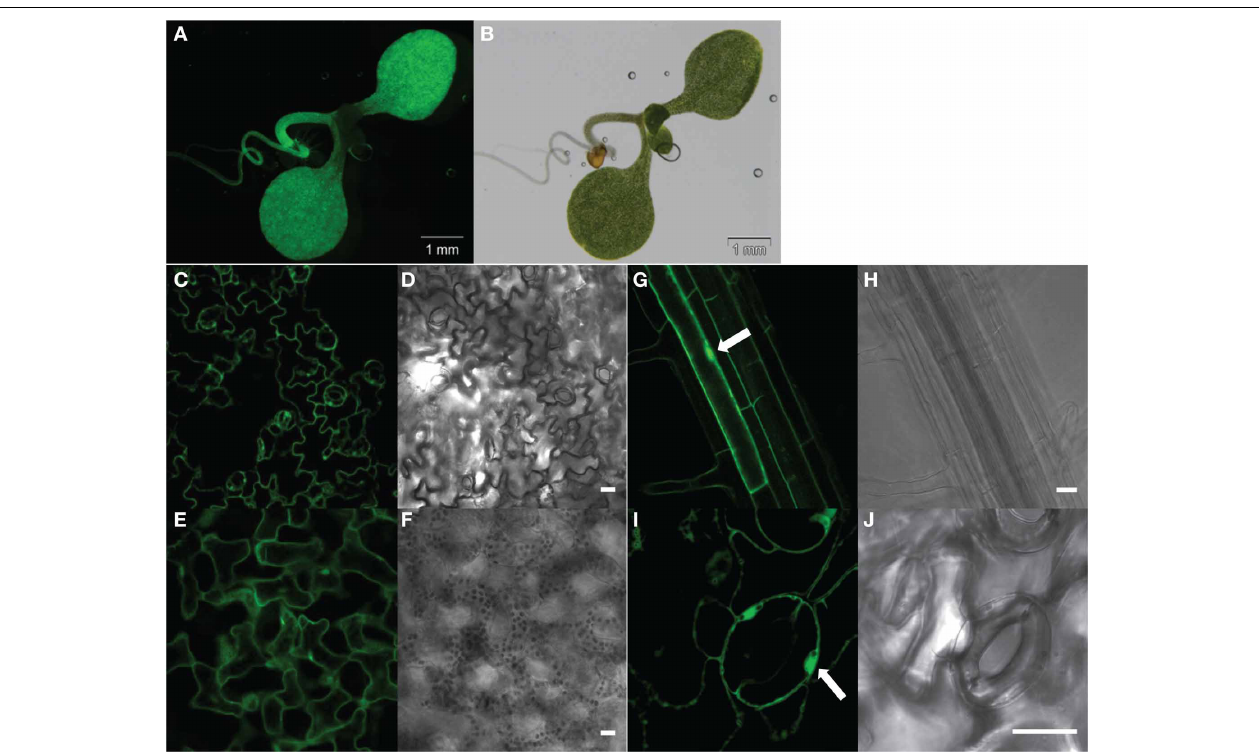
FIGURE 2 | Constitutive expression of the G5A fusion protein in all tissues of Arabidopsis thaliana seedlings. Seven (A–F) or 21 day-old (G–J) plants of the G5A line were checked for reporter expression by excitation of GFP (at λ ex = 488nm) under a stereo microscope (A,B) or a confocal microscope (C–J) . Fluorescence emission by GFP is shown in (A,C,E,G,I) and corresponding bright field images are shown respectively in (B,D,F,H,J) .